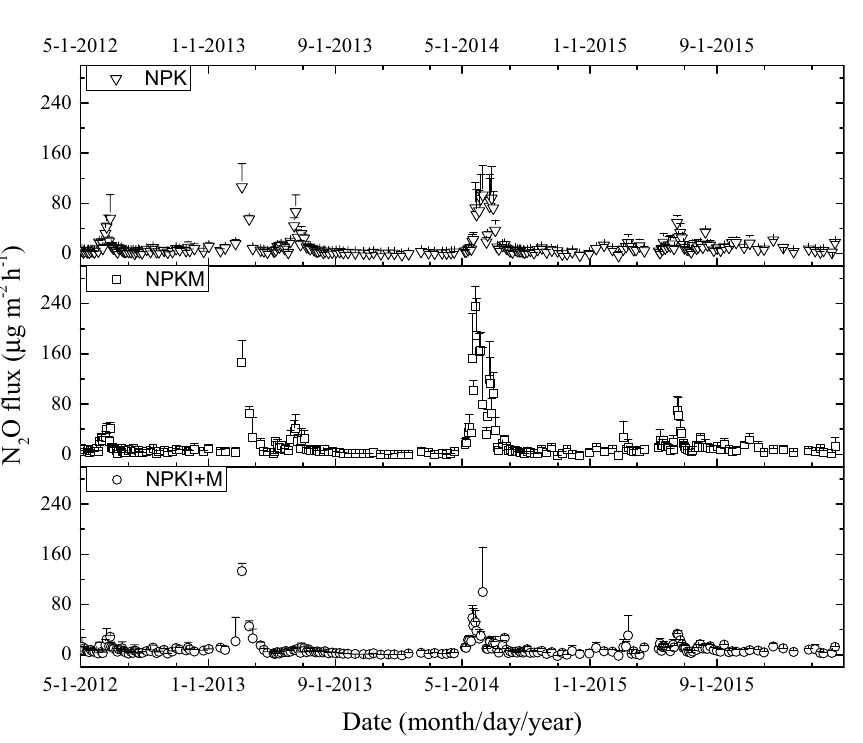
Figure 3. Seasonal variations of N 2 O fluxes in NPK, NPKM and NPKI + M treatments from May 2012 to April 2016. Error bars represent the standard deviation (n =